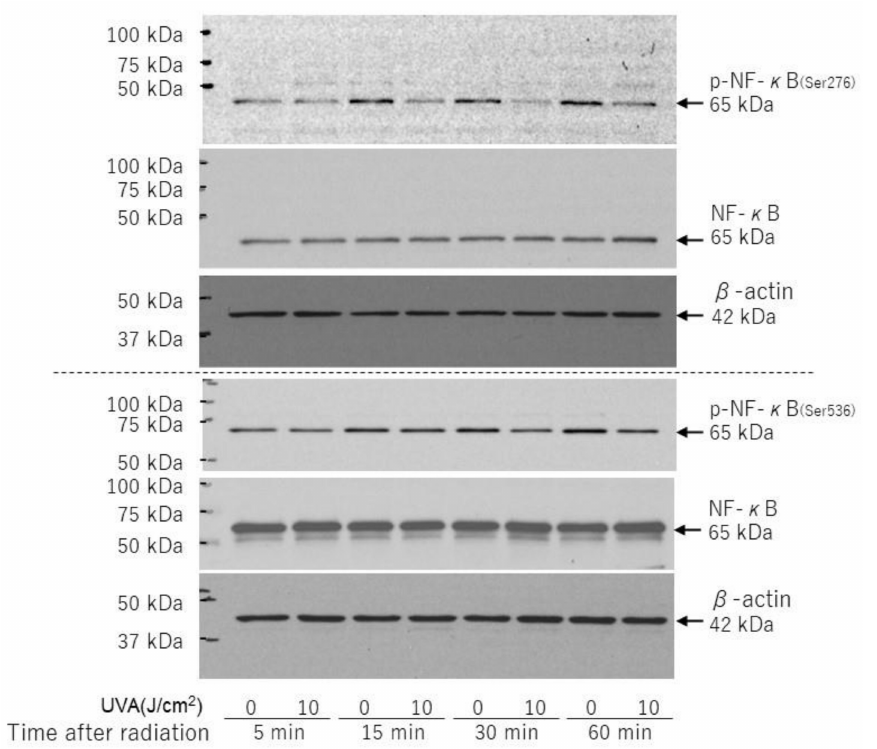
Figure 10. Effects of UVA on phosphorylation and protein levels of NF-kB(Ser276/Ser536). HDFs were exposed to UVA at the indicated doses in culture and cell lysates prepared at the indicated times post-irradiation were subjected to western blotting as described in the Materials and Methods section. Representative immunoblots from three independent experiments are shown.